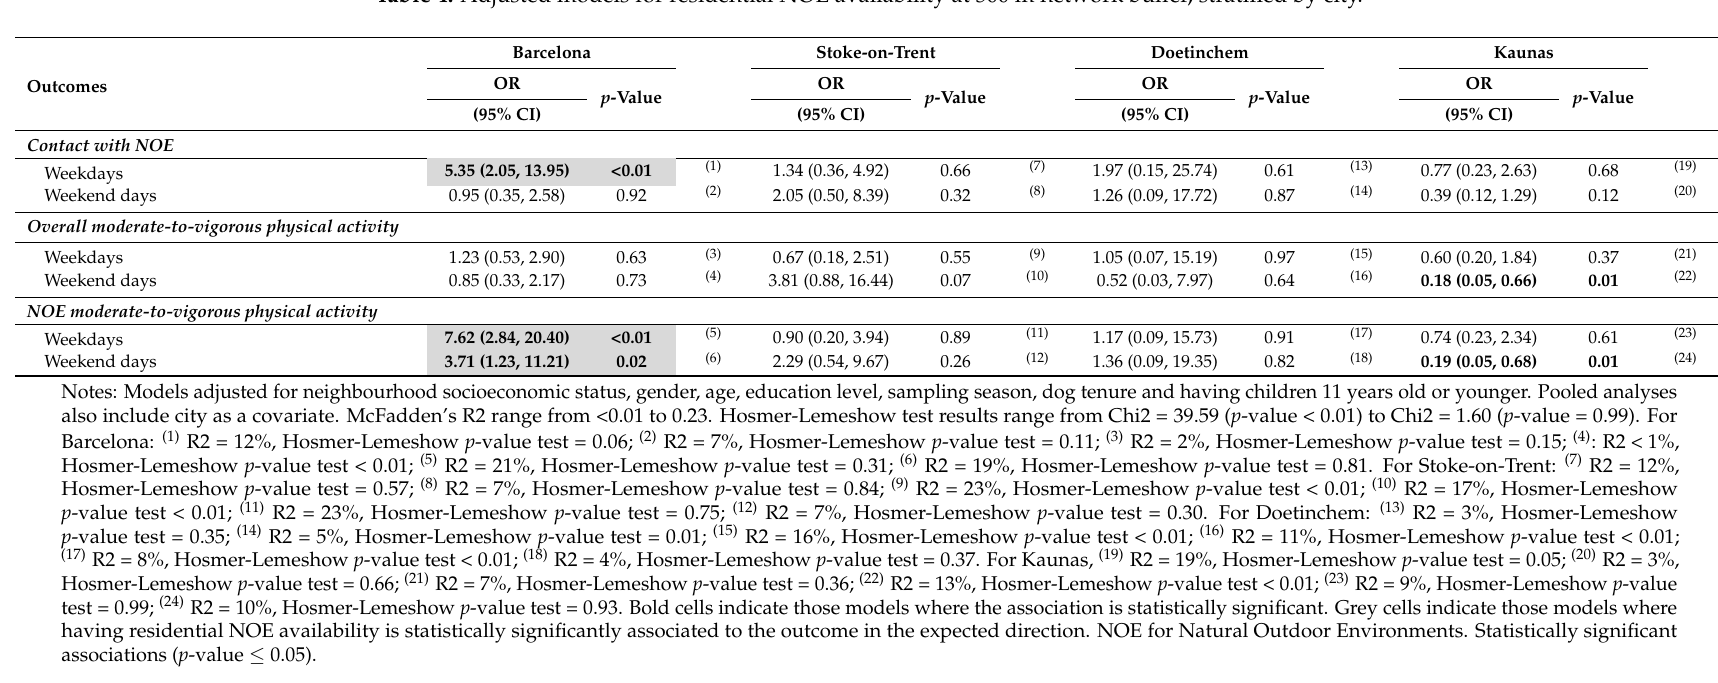
Table 4. Adjusted models for residential NOE availability at 300 m network buffer, stratified by